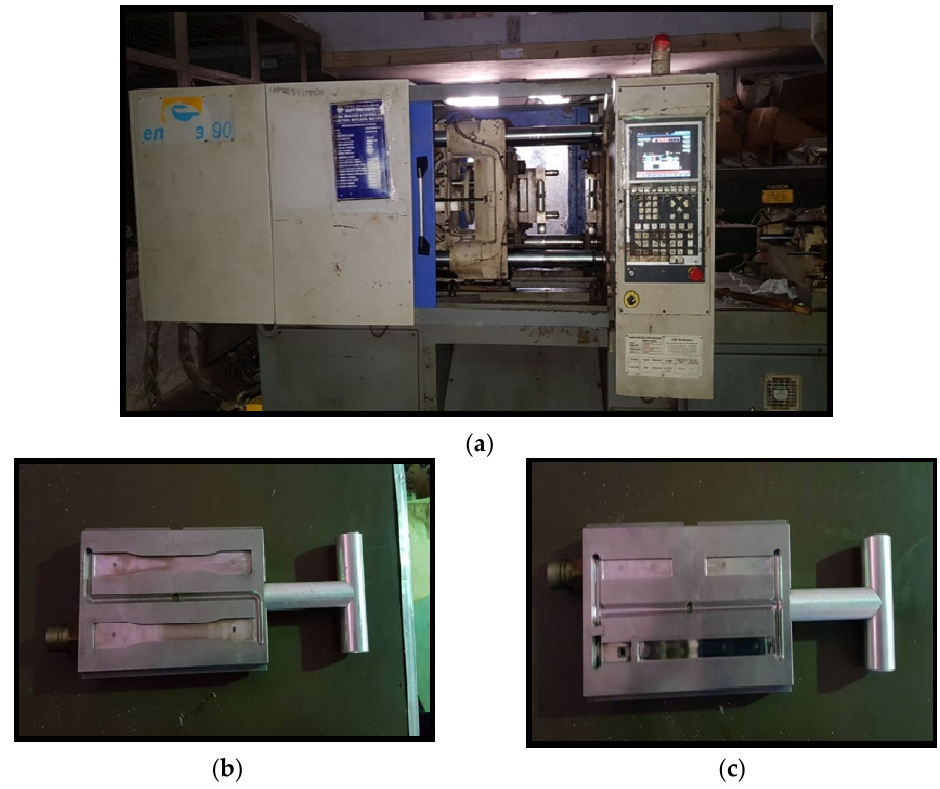
Figure 2. ( a ) Injection Molding Setup ( b , c ) Dies for tensile and flextural specimen.